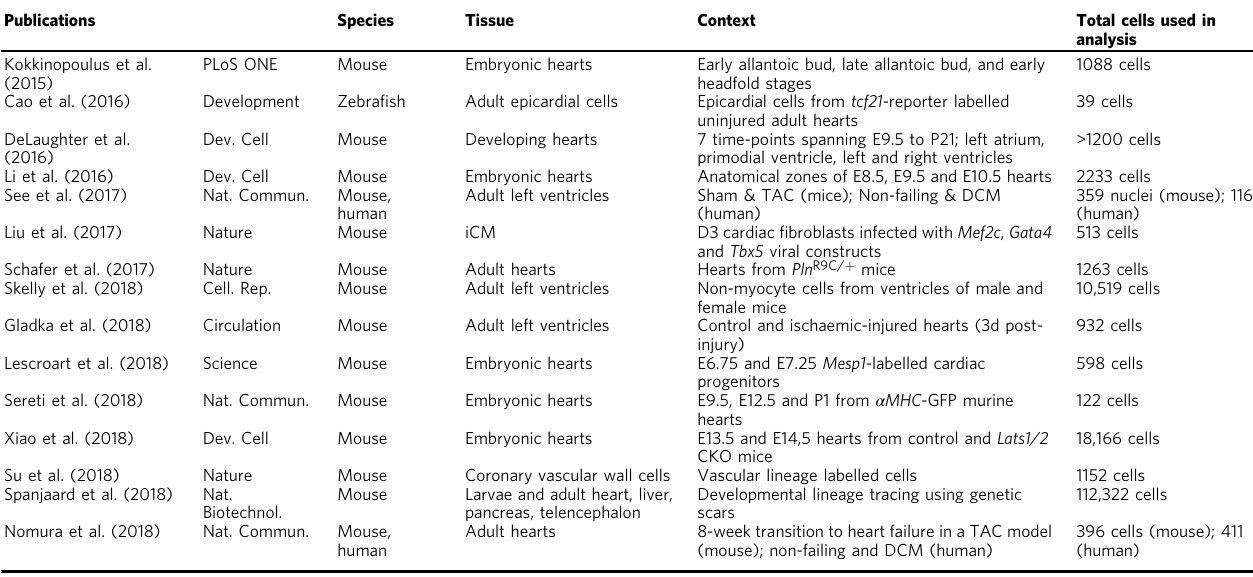
Table 1 Single-cell cardiac RNA-seq